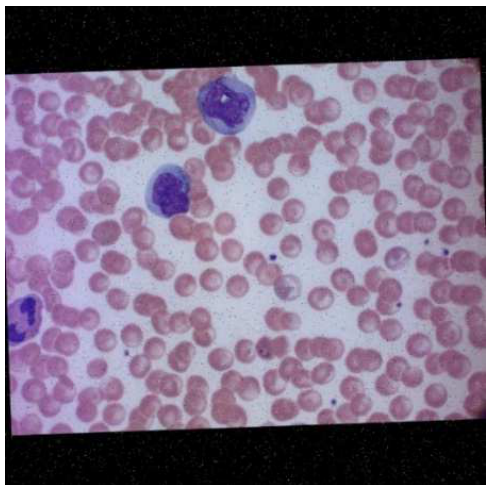
Figure 7. Microscopic image of blood smear after augmentation.